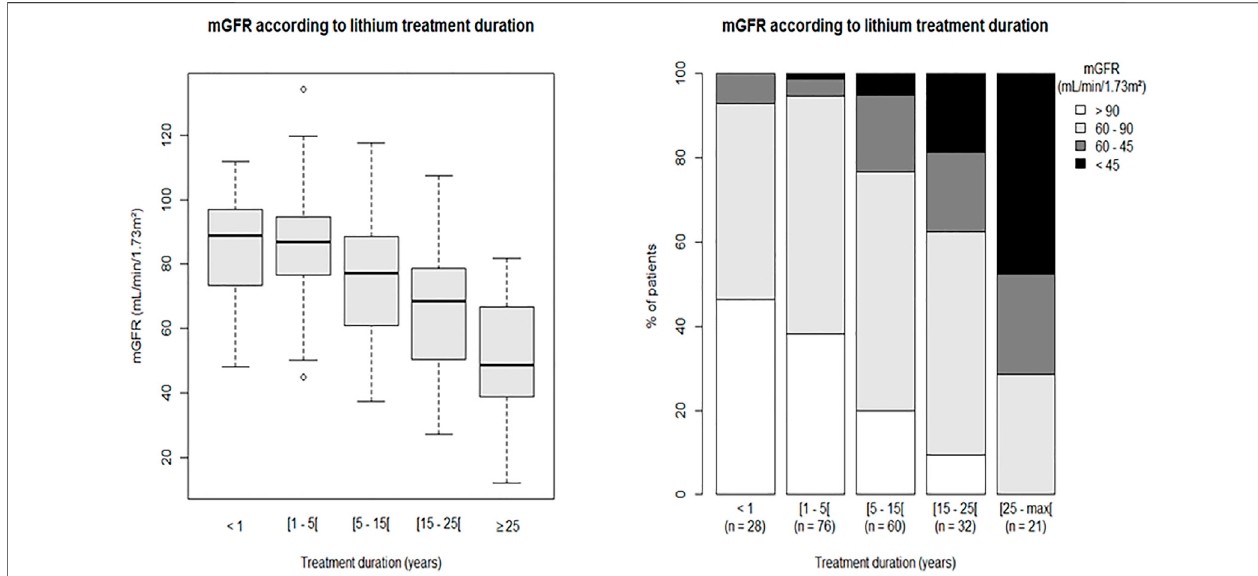
FIGURE 1 | mGFR according to lithium treatment duration. Left panel: median and range of mGFR according to lithium treatment duration. Right panel: stacked bars representing mGFR classes according to lithium treatment duration. mGFR: measured glomerular fi ltration rate.